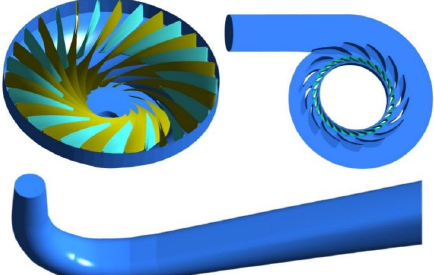
Figure 4. Three ‐ dimensional model of the Francis turbine; ( top left ): runner with blades and splitters; ( top right ): spiral casing with distributor, ( bottom ): draft tube.